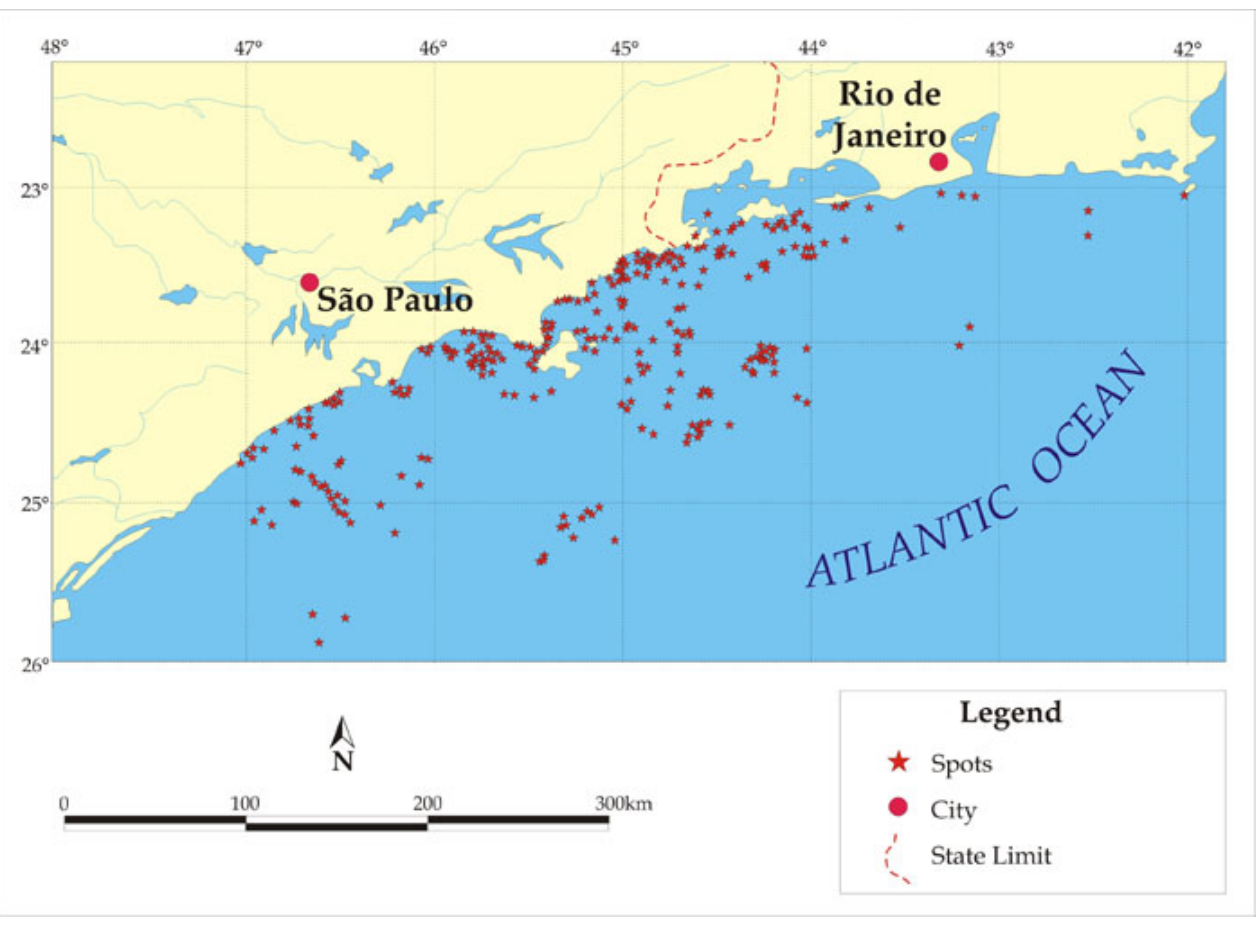
Fig. 10 . Fishing spots used by 5–12 t boats, marked by a fisher from Picinguaba. Data were obtained by a fisher who uses lines and nets in a boat that stays out of Picinguaba for about a week. Data included 365 fishing